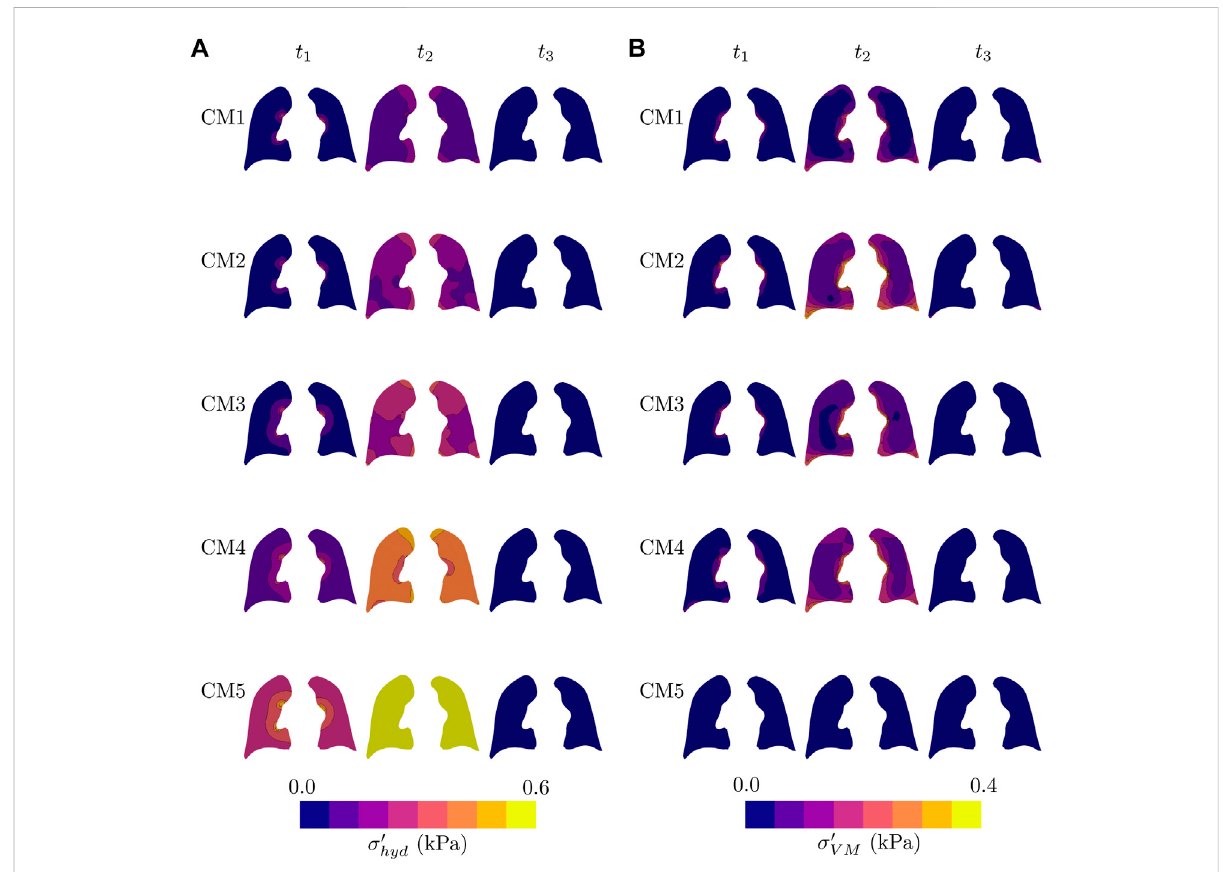
FIGURE 6 Temporal evolution of all lung models during one respiratory cycle of pressure-controlled mechanical ventilation: (A) Hydrostatic stress fi eld, and (B) von Misses stress fi eld. Fields are plotted in the current con fi